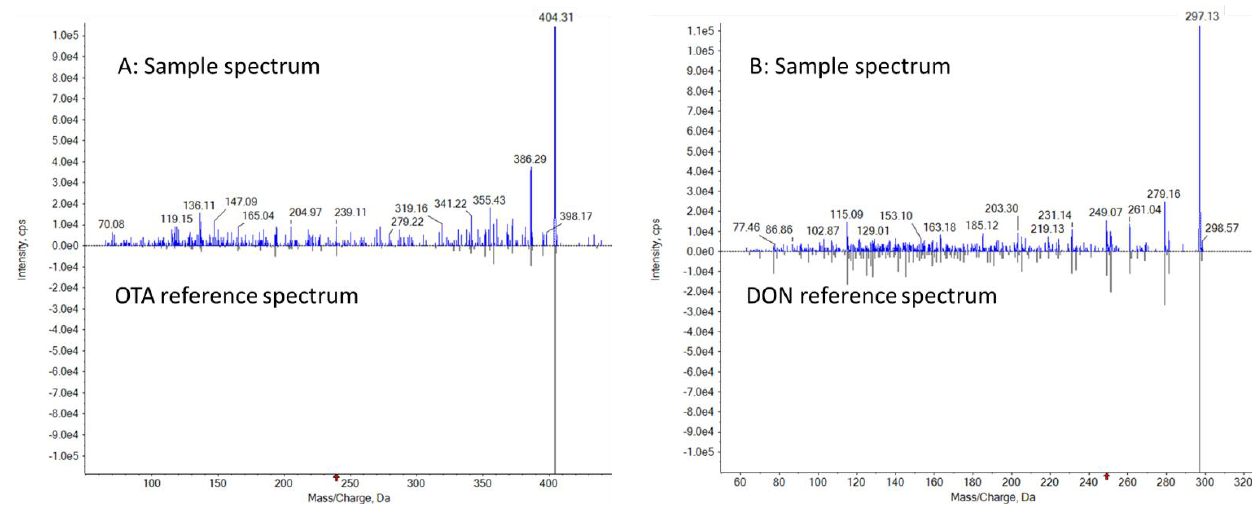
Figure 3. Mirror comparison of EPI spectra of OTA and DON collected from dried samples. ( A ): OTA Library search Fit = 84, Reverse Fit = 100, Purity = 84. ( B ): DON Library search Fit = 94, Reverse Fit = 95, Purity = 85.